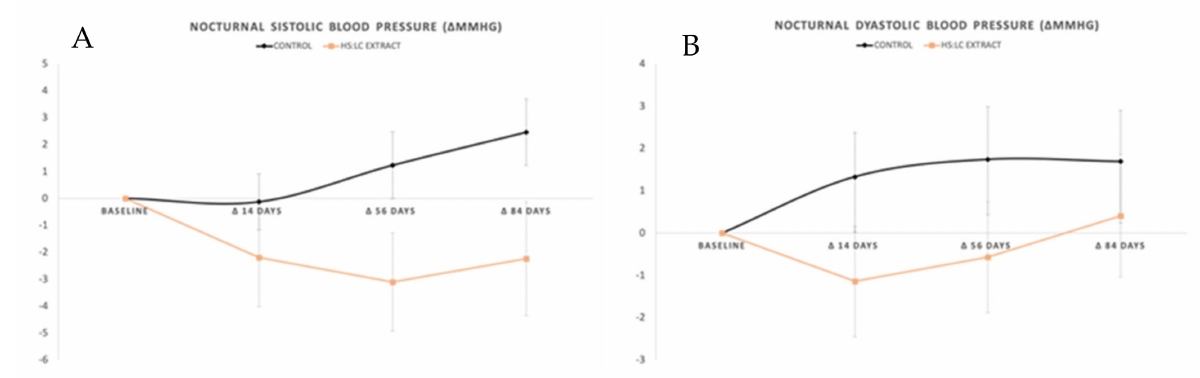
Figure 3. ( A ) Systolic blood pressure and ( B ) diastolic blood pressure determined by ABPM. Values are expressed by the increase (in mmHg) between the baseline and each control day.